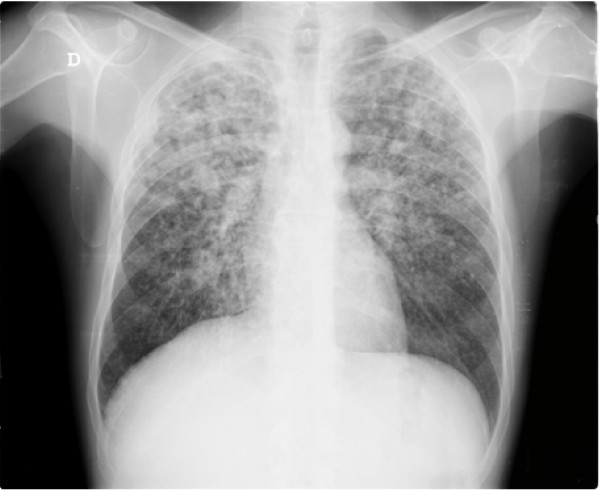
Chest X-ray on admission.